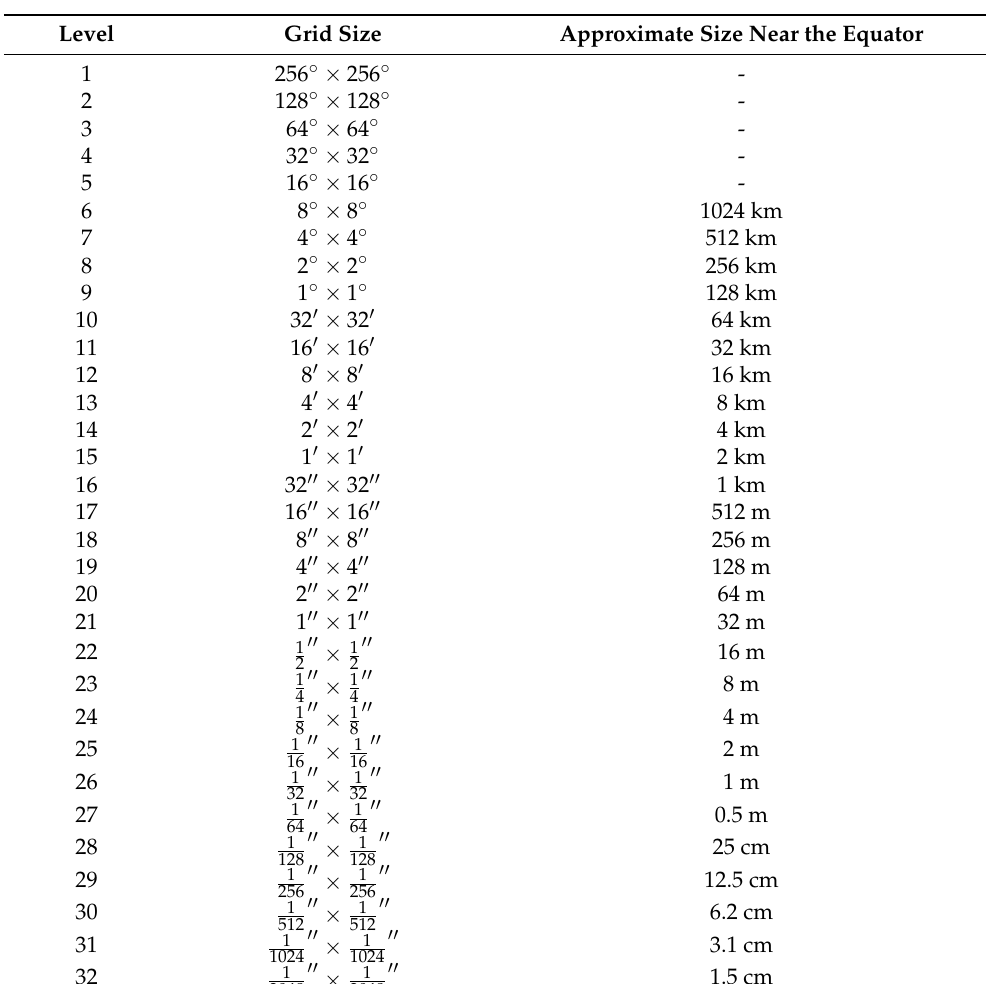
Figure 3. GeoSOT 3D meshing [26]. Table 1. GeoSOT Grid Level